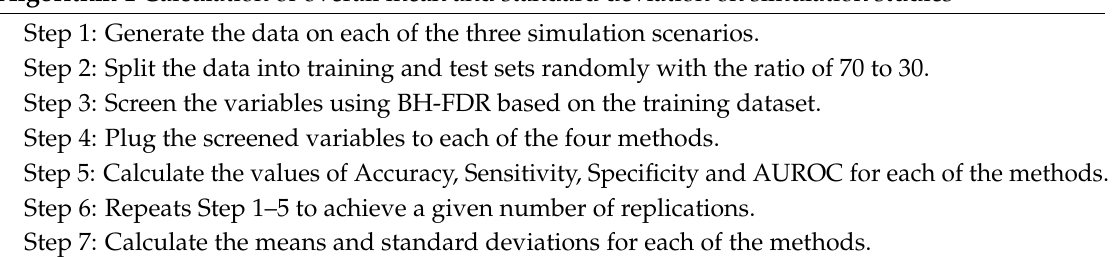
Algorithm 1 Calculation of overall mean and standard deviation on simulation studies